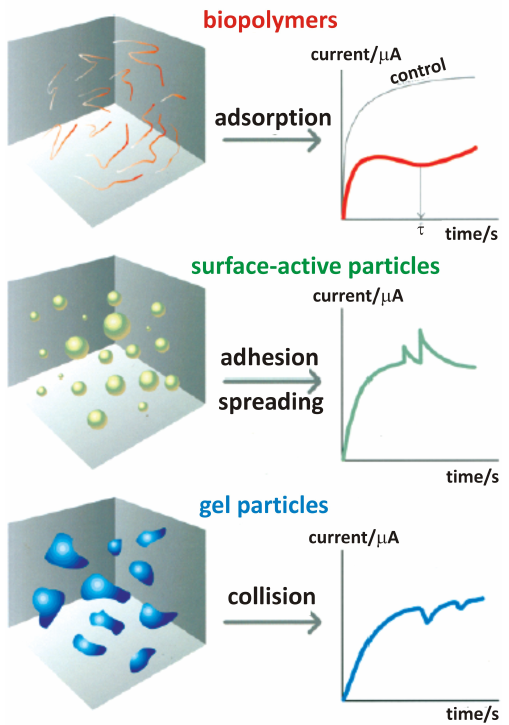
Figure 2. Illustration of different classes of organic constituents in seawater and their electrochemical signals at the electrode: biopoly- mer and small colloids, surface-active particles and gel particles (adapted from Svetliˇci´c et al.,